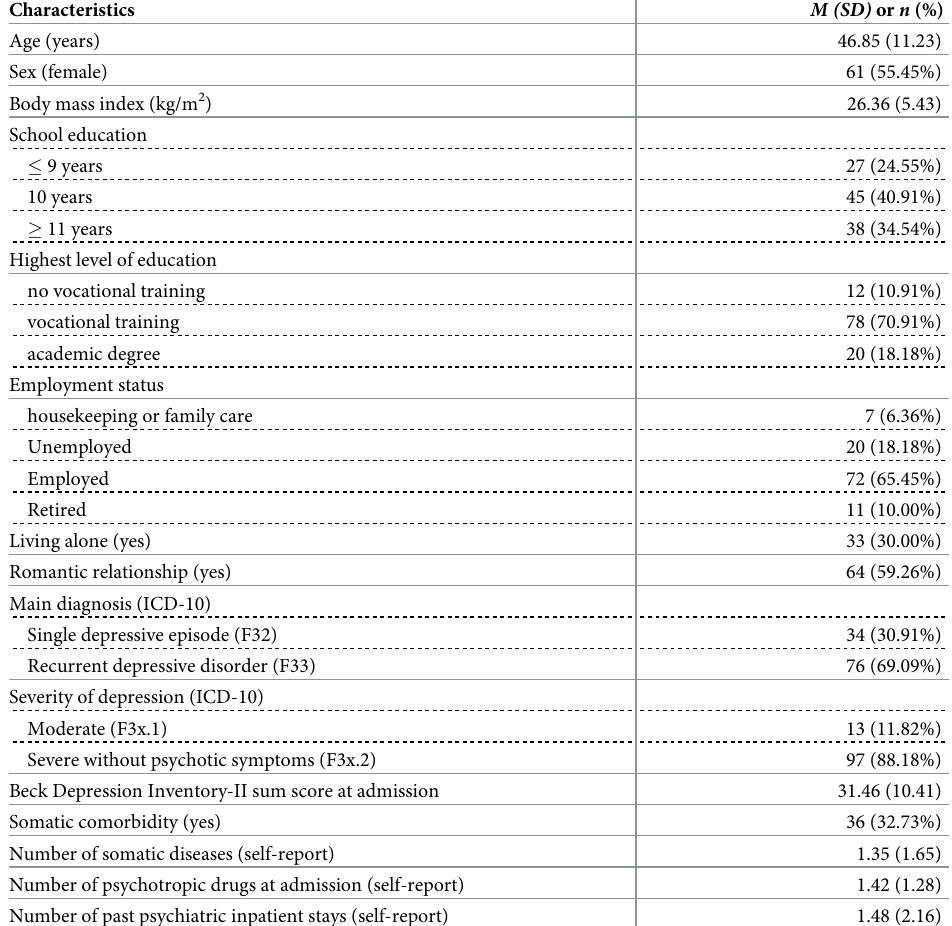
Table 1. Characteristics of enrolled participants (pre-treatment, n =